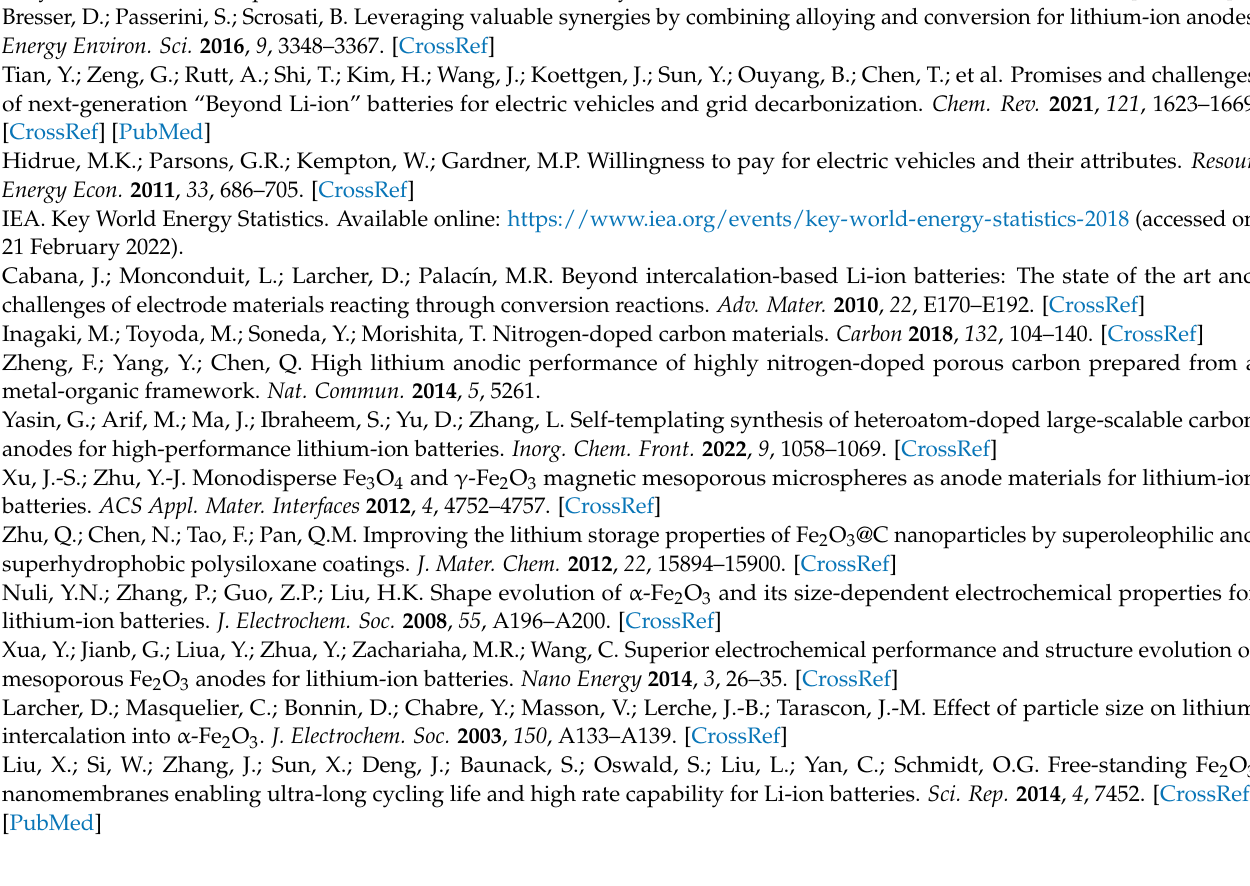
process; Figure S10: (a–c) EIS data (black color: FO300, red color: FO500 and blue color: FO700) and (d) equivalent circuit used to calculate R ct1 , R ct2 and R ct3 parameters represented in the Figure 6 during second cycle; Figure S11: SEM images of FO500 (a) before and (b) after cycling experiments; Table S1: The charge transfer resistances calculated for three cycles for FO300, FO500 and